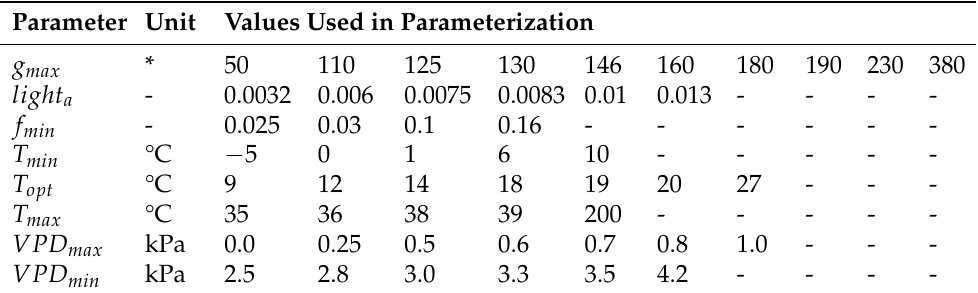
Table 3. Set of static parameters used in the Jarvis model based on the Table 2. The Jarvis model with each combination of parameters in this table was validated against measured stomatal